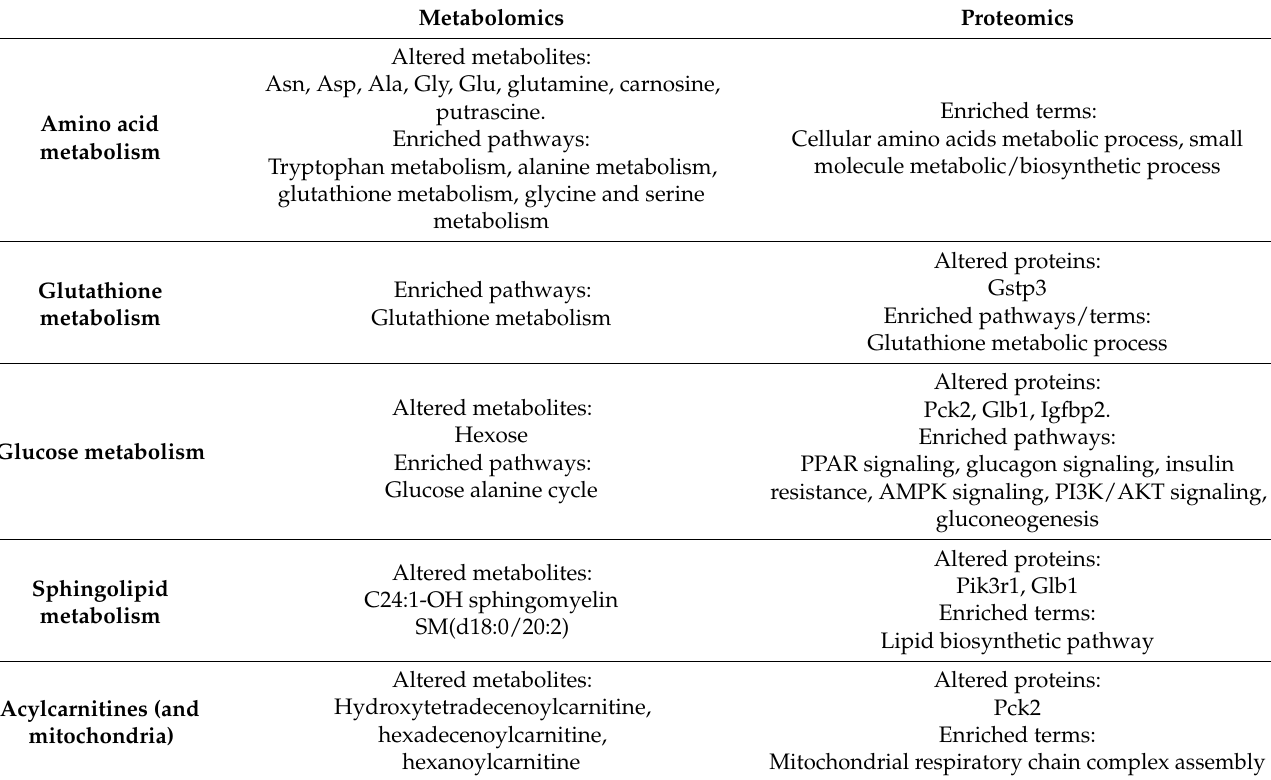
Table 1. Integrative analysis of proteomics and metabolomics in the liver. Metabolomics